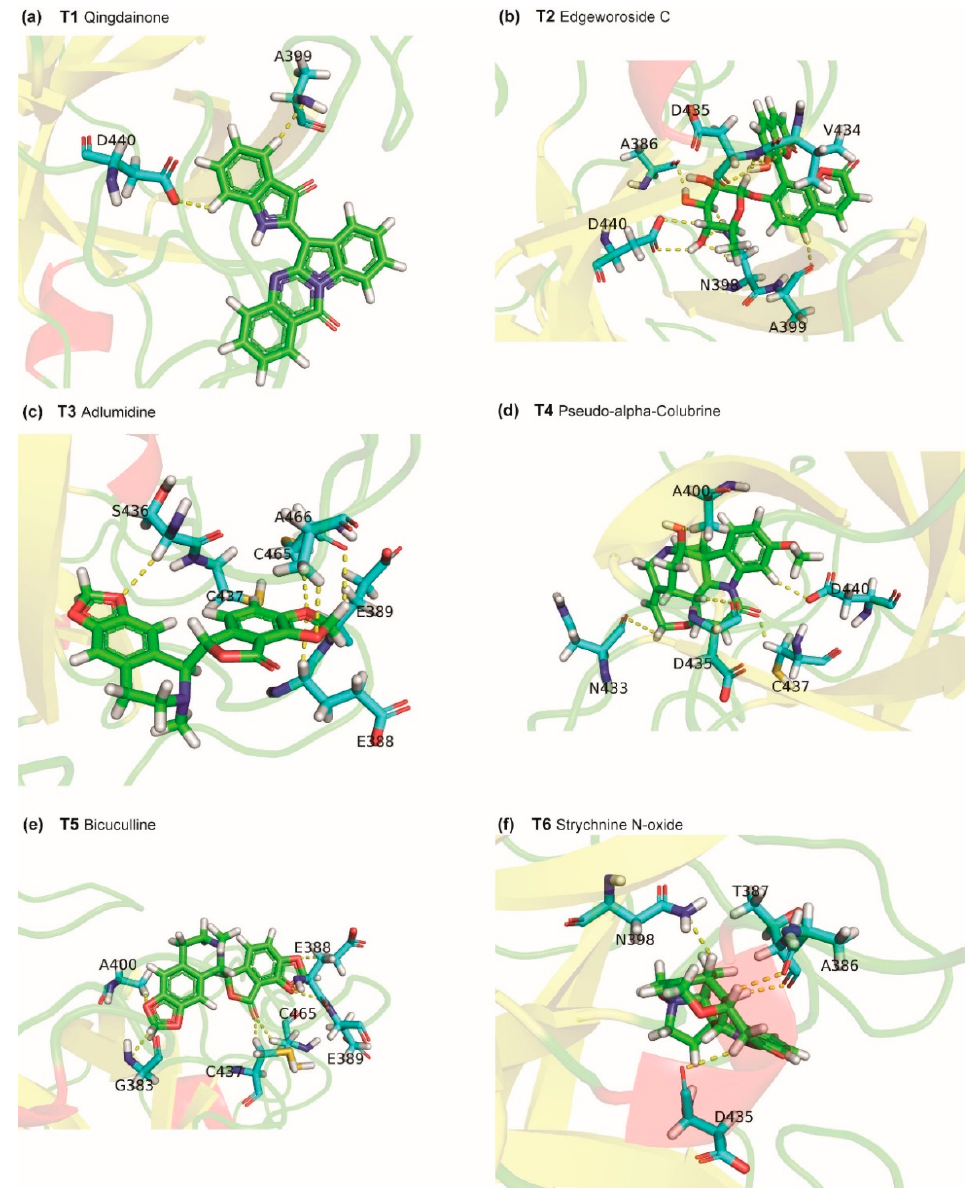
Figure 5. Cartoon representation of the protein-ligand interactions of the phytochemical inhibitors of TMPRSS2. Interactions of TMPRSS2 residues with atoms of ( a ) T1, ( b ) T2, ( c ) T3, ( d ) T4, ( e ) T5, and ( f ) T6. The carbon atoms of the ligand are shown in green colour while the carbon atoms of the amino acid residues in TMPRSS2 are shown in cyan colour. TMPRSS2 residues interacting with the ligand atoms via hydrogen bonds or π - π stacking are labelled with the corresponding single letter residue code along with their position in the protein sequence. The hydrogen bonds and π - π stacking are displayed using yellow and red dotted lines, respectively.